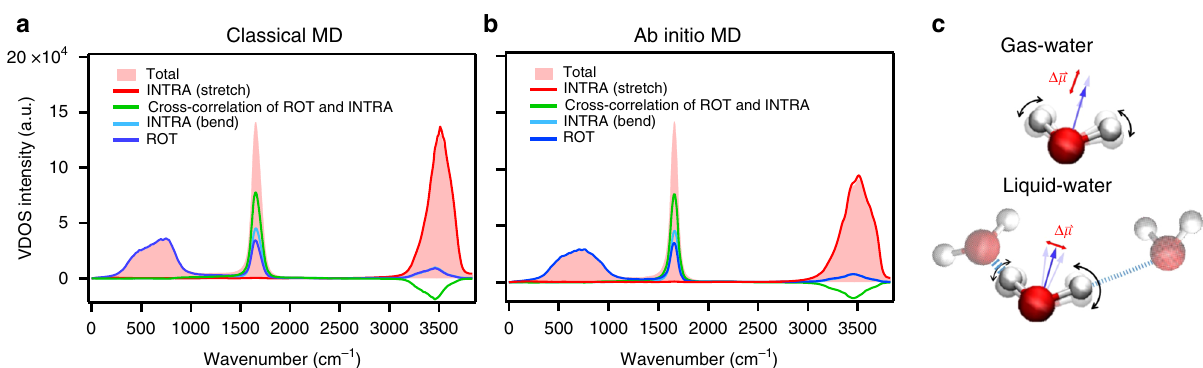
Fig. 5 Decomposed vibrational density of states (VDOS) spectra of neat H 2 O. a Classical force fi eld MD with the POLI2VS model 53 and b AIMD simulation at the revPBE0-D3(0) level of theory. The frequency of the POLI2VS model is scaled with a factor of 0.96 to account for nuclear quantum effects. The frequencies of the bending and stretch modes for the revPBE0-D3(0) model are corrected via the procedure described in ref. 54 . The red region illustrates the total VDOS spectrum of neat H 2 O. The differently colored lines represent the contribution of different motions. c Schematics of water molecules in the gas and liquid phase. Strong (weak) hydrogen-bonds are represented by thick (thin) broken lines. The blue arrows represent the direction of the dipole moment of the highlighted water molecule, while the red lines represent the direction of the change in the dipole moment (transition dipole * moment, Δ μ